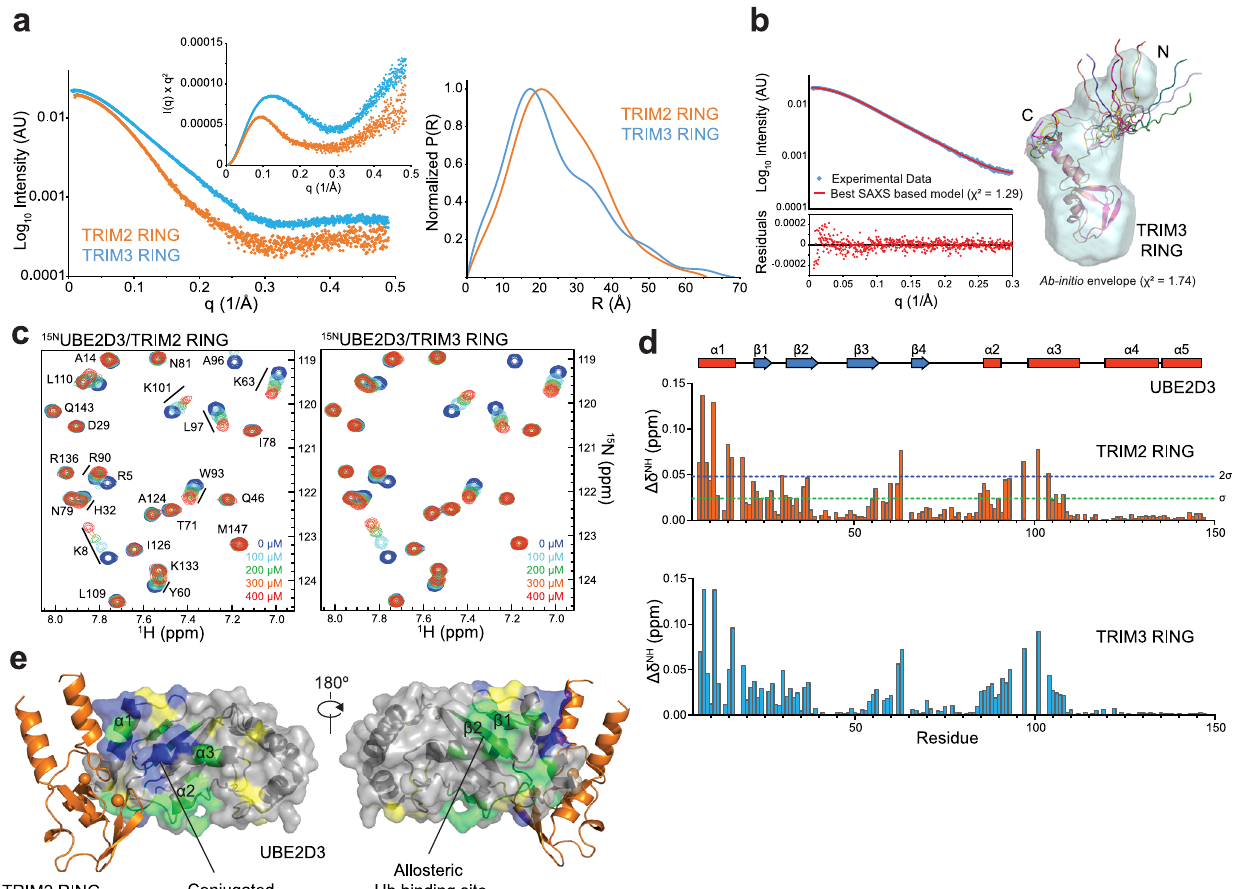
Fig. 4 | Small-Angle Xray scattering and NMR spectroscopy. a X-ray scattering pro fi les, Kratky plots and normalized pair-distribution functions P(R) for the RING domains of TRIM2 (orange) and TRIM3 (cyan). b Left panel : agreement of the experimentalSAXSintensitiesofTRIM3RING(cyan)withthosecalculatedbyFoXS for the representative conformer (lowest χ 2 ) derived from molecular dynamics (red). Rightpanel :overlapofthebestDAMMIFabinitiomolecularenvelopeandthe ensembleofthe10lowest χ 2 conformersobtainedbyXplor-NIH.Therepresentative conformer hasbeen overlapped to the abinitioenvelopeusing SUPCOMB and the remaining nine protomers have been aligned to the representative one using residues 19 – 88 (treated as a rigid body in the modeling protocol). c Details of the